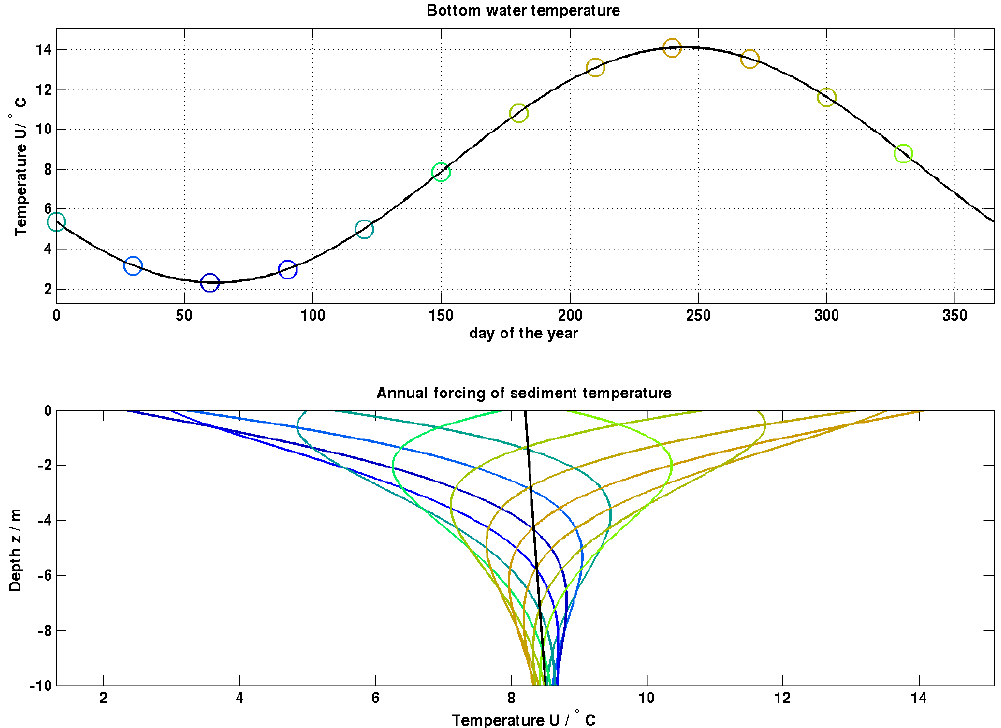
Figure 1. Bottom water temperature (top panel) as input to the forward model operator and the solution (bottom panel) at different days of the year. A constant thermal diffusivity of κ = 8 × 10 − 7 m 2 s − 1 was used and the geothermal gradient (black in the lower panel) was set to c g = 0 . 03Km − 1 . The bottom water temperature function is a cosine with a mean value of 8 . 2 ◦ C, an amplitude of ± 5 . 9K and the minimum on the 62 day of the year. The colors indicate the bottom water temperature and thus the day of the year when the temperature–depth profile is plotted. The bright orange temperature–depth profile is the solution on the 220th day of the year, when the bottom water temperature is near the annual maximum of 14 . 1 ◦